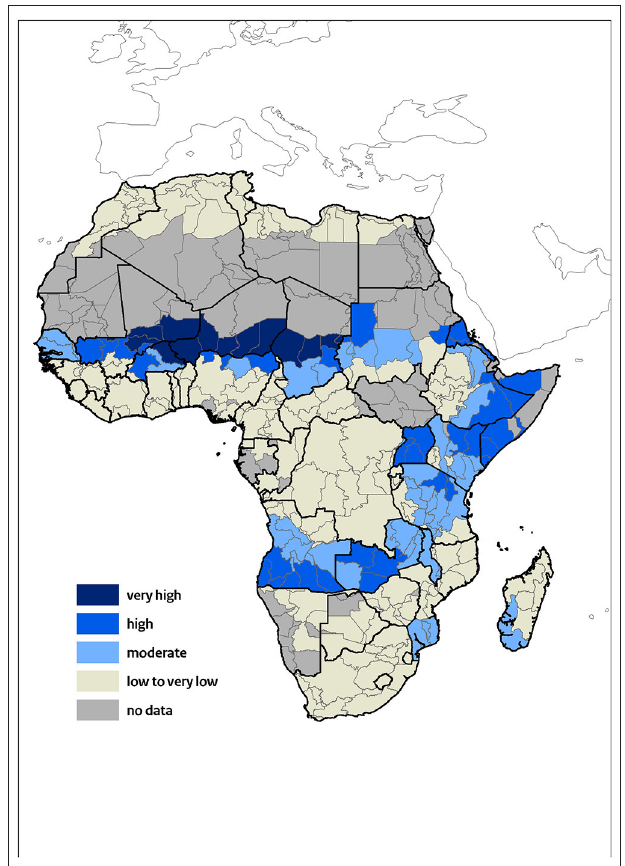
FIGURE 4 | Probability map of regions facing migration associated with water stress by 2050 under the Shared Socioeconomic Pathway 2